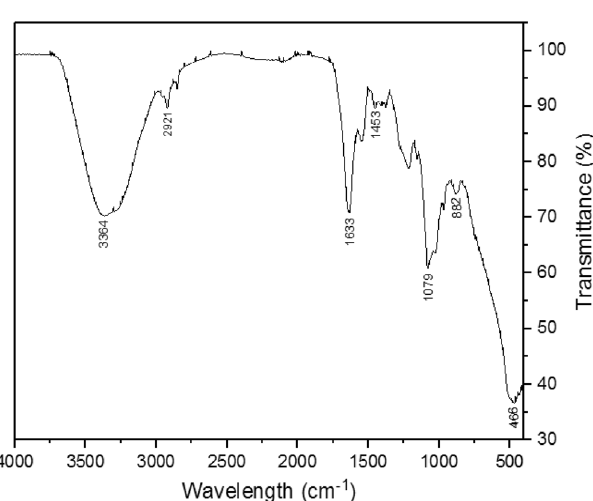
Figure 4. FTIR spectrum of purified